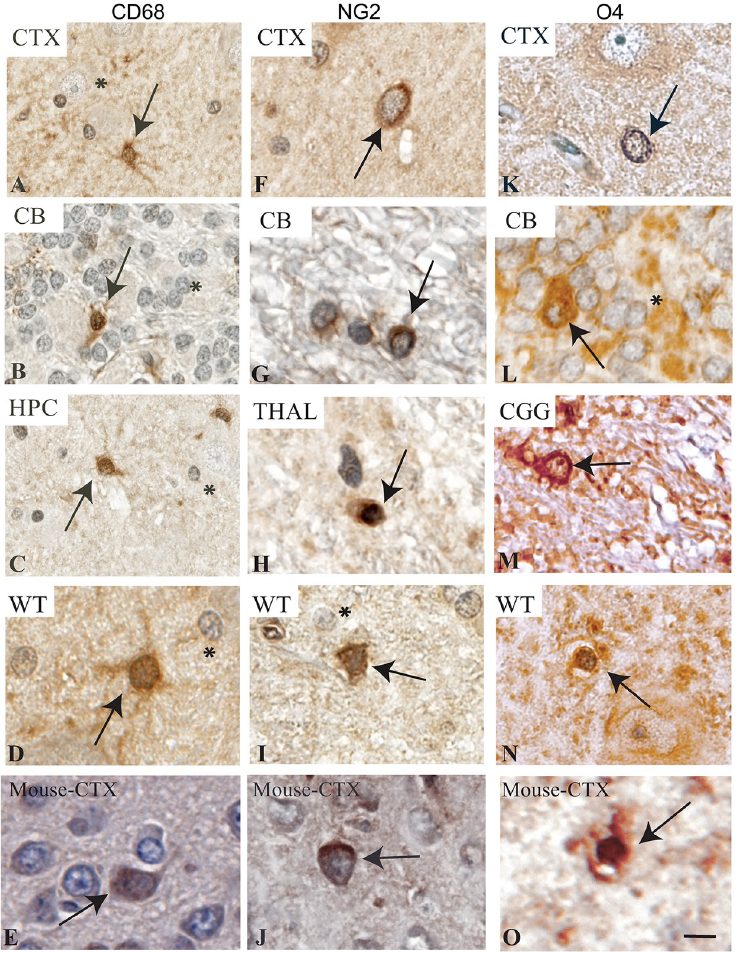
Fig 2. Immunolabeling of microglial and pre-oligodendrocyte markers in the NF1 mutant and wild-type miniswine brain. Brain regions are identified as cortex (CTX), cerebellum (CB), thalamus (THAL), hippocampus (HPC) and cerebral aqueduct (CGG). A-D: CD68+ expression in the cortex, cerebellum, hippocampus, and thalamus, localized to the membrane of microglia. Arrows indicate ameboid-like microglia. E: CD68+ expression in mouse cerebral cortex. F-I: NG2+ expression in the cortex, cerebellum, and thalamus, localized to the membrane and cytoplasm of oligodendrocyte progenitors. Arrows indicate immature oligodendrocytes. J: NG2+ expression in mouse cerebral cortex. K-N: O4+ expression in the cortex, cerebellum, cerebral aqueduct, and thalamus localized to the membrane of pre-oligodendrocytes. Arrows indicate pre-oligodendrocytes. O: O4+ expression in mouse cerebral cortex. Asterisks indicate lack of immunolabeling. Scale bar: 50 μ m. WT animals shown as a healthy control.